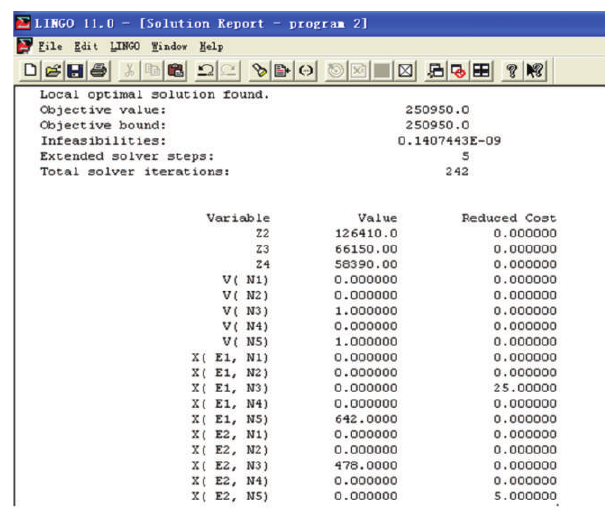
Figure 2: Results of the ordinary